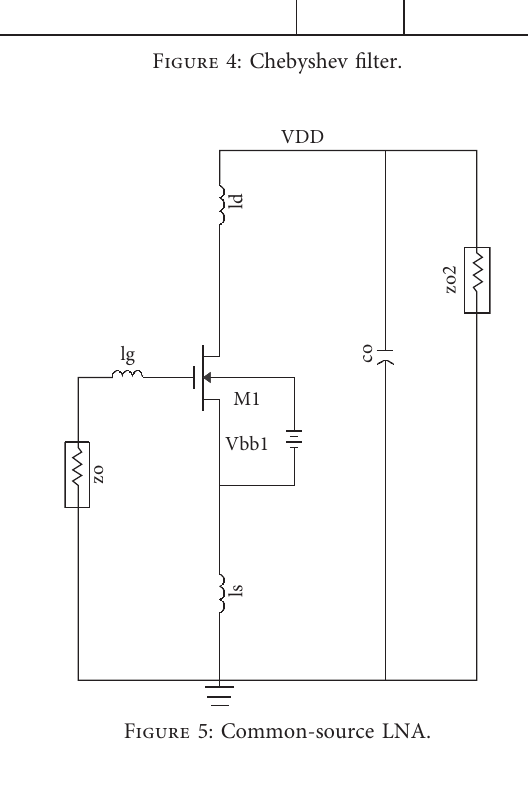
Figure 5: Common-source LNA.